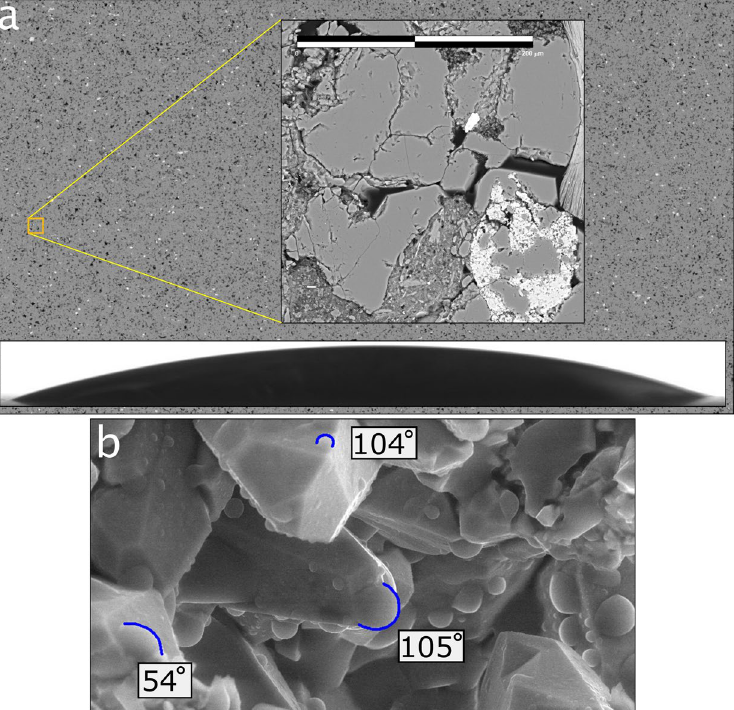
Figure 1. ( a ) Thin-section (2.8 cm × 1.6 cm) of a low-permeability Cardium sample for which back- scattered electron (BSE) images were acquired at high resolution ( < 250 nm) using an FEI Quanta FEG 250 environmental field emission scanning electron microscope (E-FESEM). The Cardium sample was first impregnated with epoxy, then finely polished and mounted on a slide. A zoom-in of the area outlined with the orange box illustrates the high spatial resolution. Fine-scale (micro- or nano-meter) pore structure information, such as that illustrated in the zoomed image, is often used to populate pore-scale models for permeability and porosity estimation. However, wettability measurements are still routinely performed at the macro-scale (see hypothetical macro-droplet superimposed on the bottom half of the thin section), which cannot be used to model fluid flow at the pore scale. ( b ) Image (collected using E-FESEM) of micro-droplet formation on a Cardium sample during a condensation/evaportation experiment illustrating water contact angle variability at the grain- (micron)